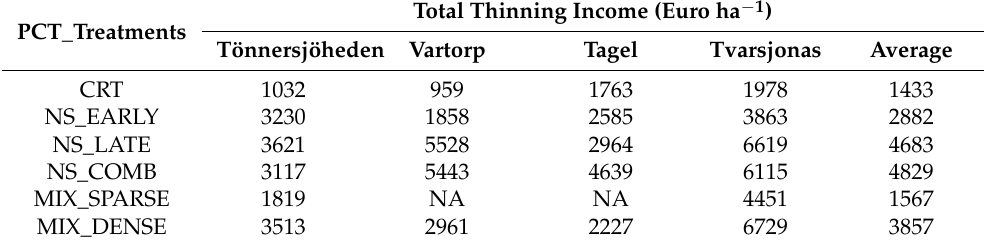
Table 3. The total thinning income obtained from different PCT strategies across experimental sites. See Figure 3 for an explanation of the treatments. There was no thinning income in two sites of MIX_SPARSE stands which is indicated by NA in the table.